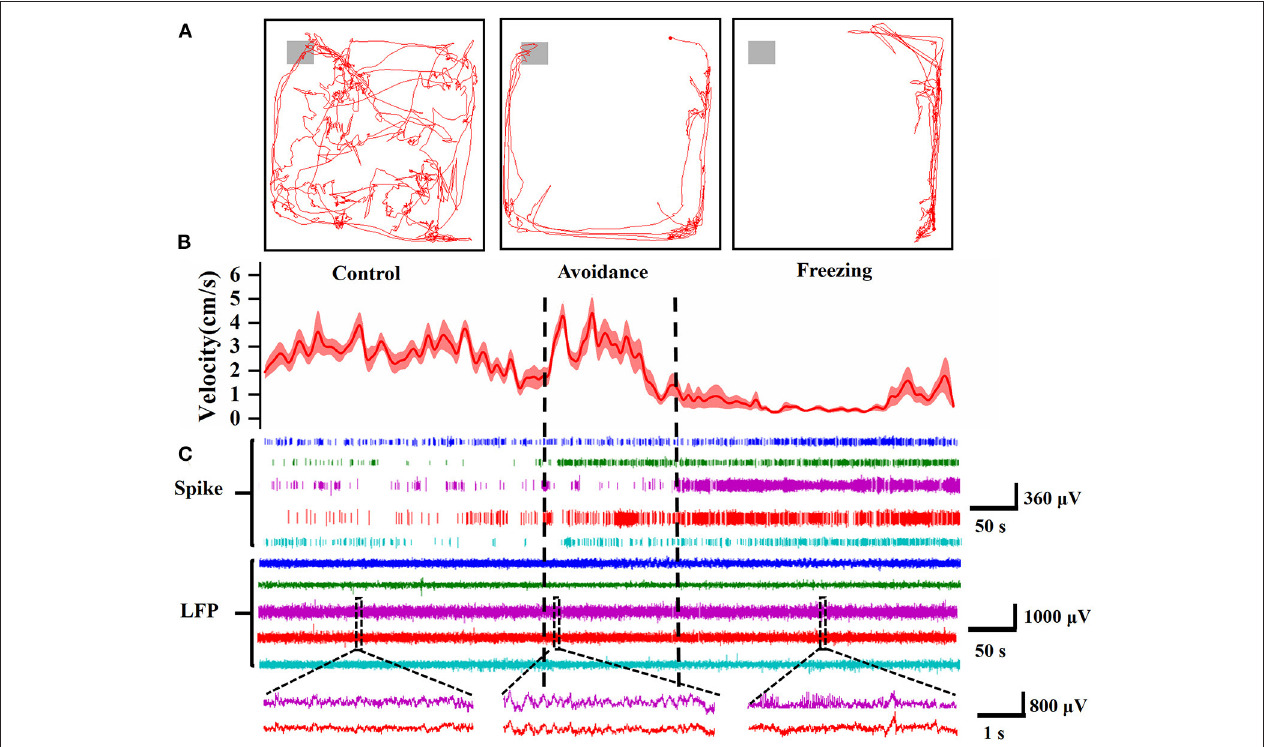
FIGURE 5 | Electrophysiological and behavioral characteristics of mice in three stages. (A) The trajectory diagram of the mouse in the control stage (left, 5min), avoidance stage (middle, 2min), and freezing stage (right, 5min), and the gray area represents the range of the 2MT paper. (B) The velocity of the mice in three stages ( n = 6 mice). (C) Spike and LFP of 5 typical channels in different mice. At the bottom is an enlarged view of the two channels corresponding to the dotted line in the LFP